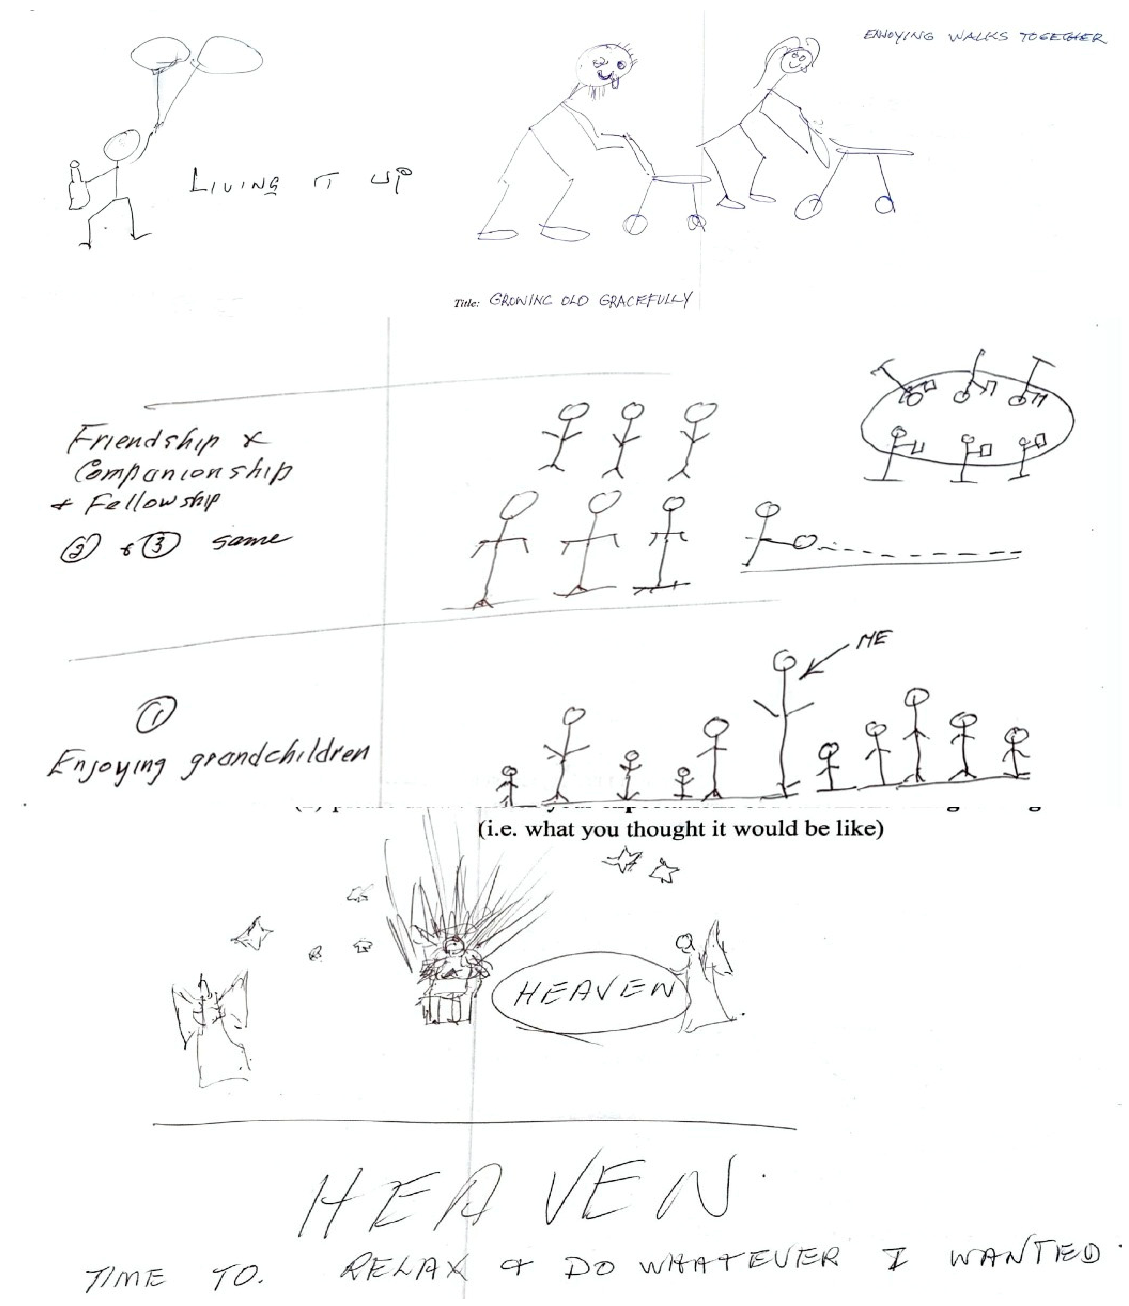
Figure 5. Expectations of retirement village life—‘living it up’, together, in heaven on earth.